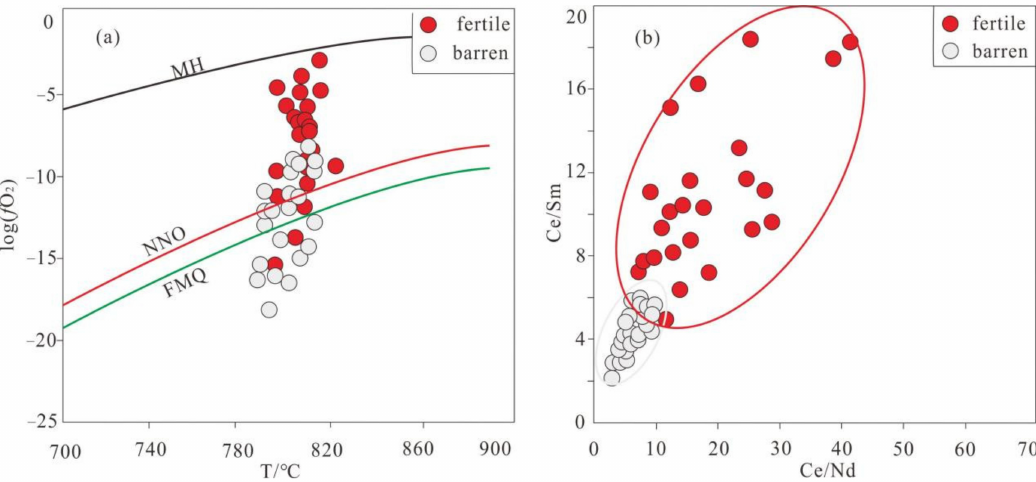
Figure 11. ( a ) Plots of T ( ◦ C) vs. log( f O 2 ) in zircon. magnetite-hematite (MH) buffer line is from [102]; nickle-nickle oxide (NNO) buffer curve is from [103]; fayalite-magnetite-quartz (FMQ) buffer curve is from [104]. ( b ) Plots of Ce/Nd vs. Ce/Sm in zircon.